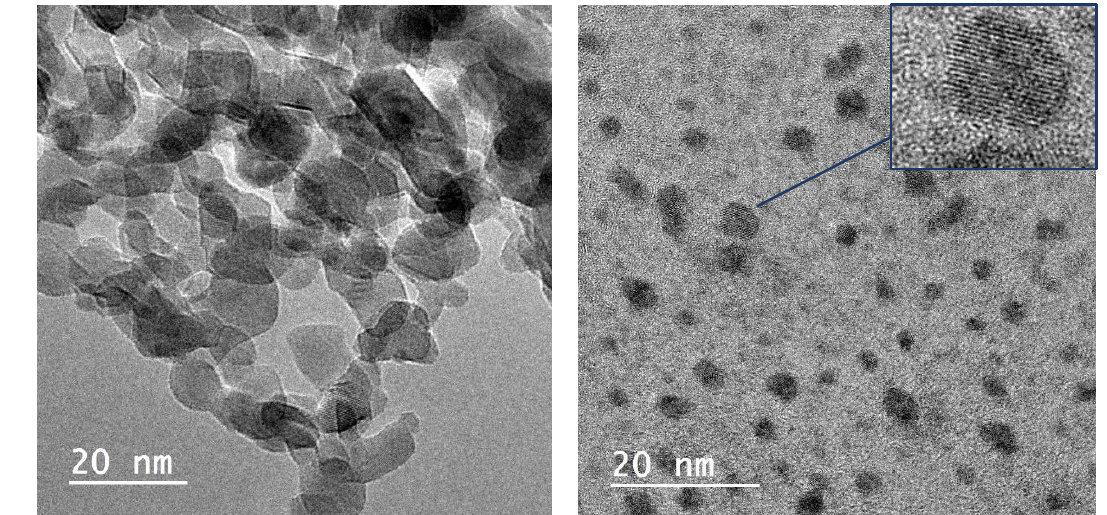
Figure 1. HR-TEM image of (left) TCDs and (right) GCDs.